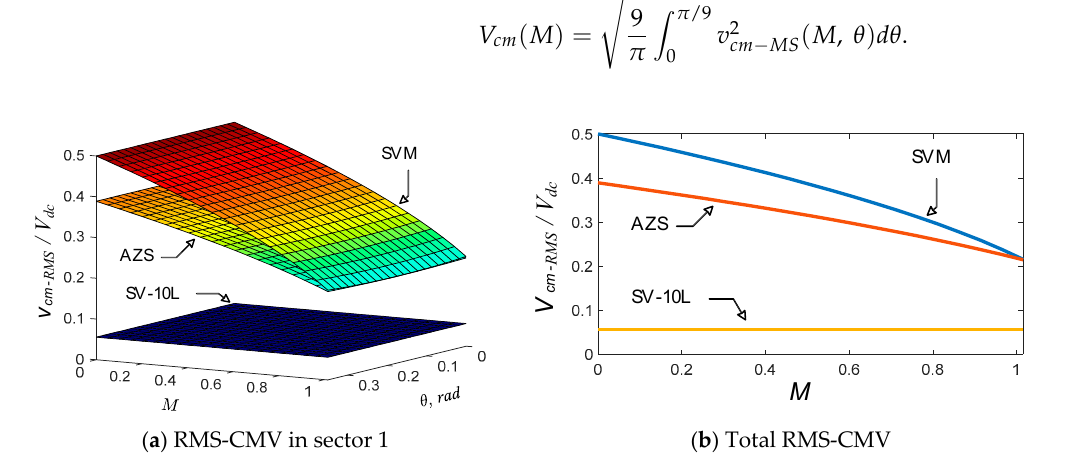
Figure 6. RMS-CMV dependency for the analyzed PWM schemes.